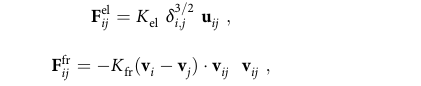
Supplementary Fig. 6a. When the height increases, the fl ow fi eld goes from circular fl ow patterns to a pattern qualitatively more akin to 3D dipoles (although quantitatively different). Finally, the state of each particle ( Θ i ) was determined by an internal chemotaxis system evolving according to the ligand concentration experienced by the cells, fi